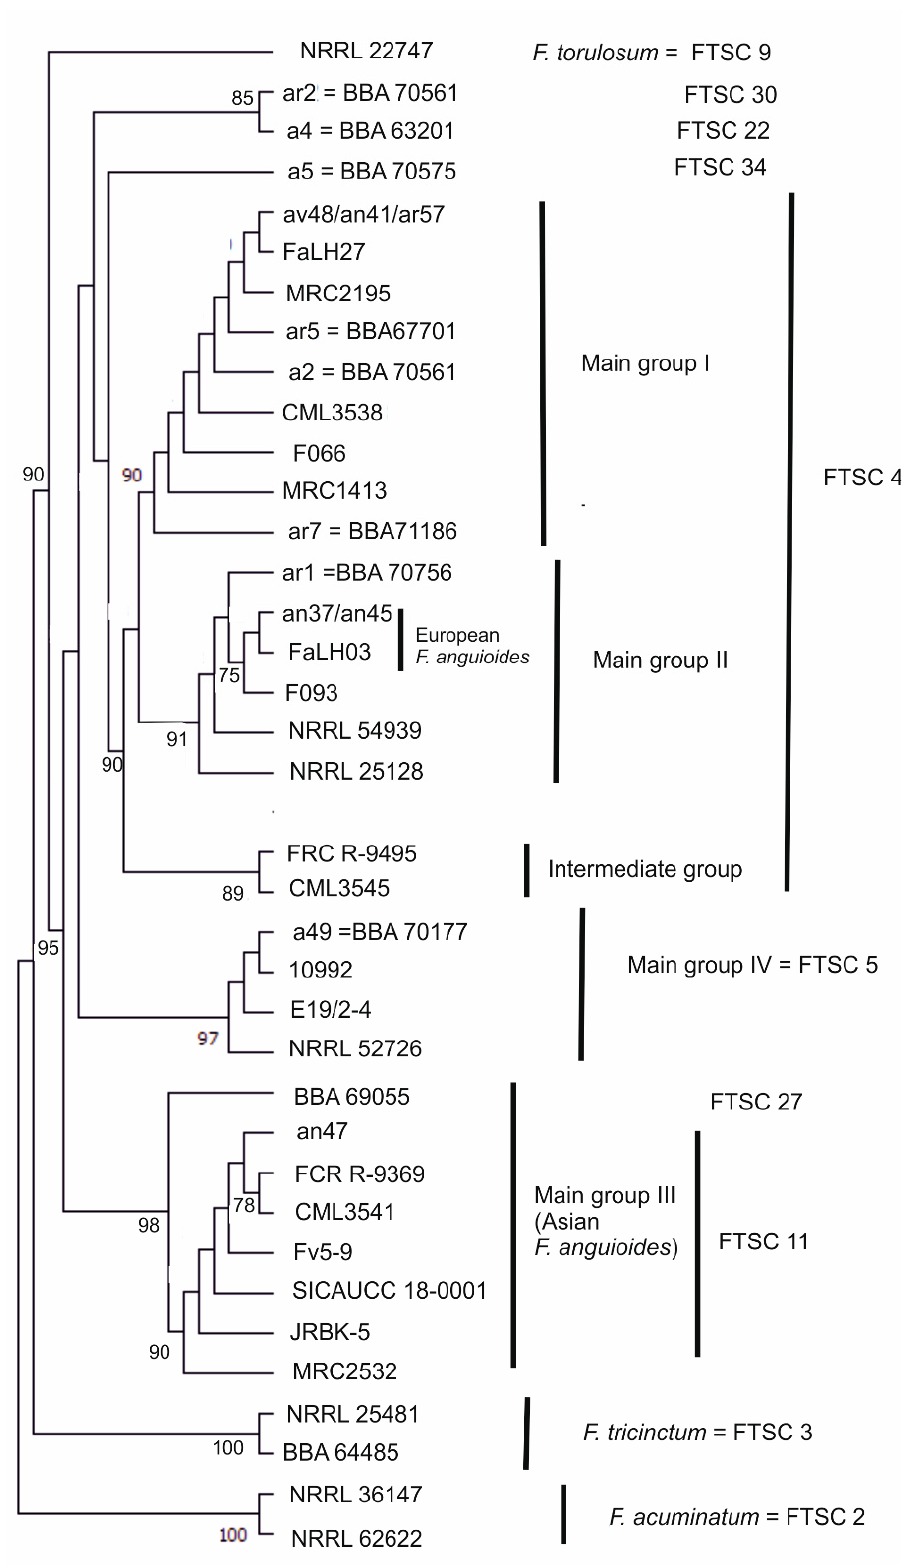
Figure 1. Maximum-parsimony consensus tree of translation elongation factor 1-alpha ( TEF1 ) se- quences. Bootstrap values are indicated above nodes based on 500 pseudoreplicates of the data. Only branches present in more than 50% of the trees are shown. Fusarium tricinctum and F. acuminatum strains are